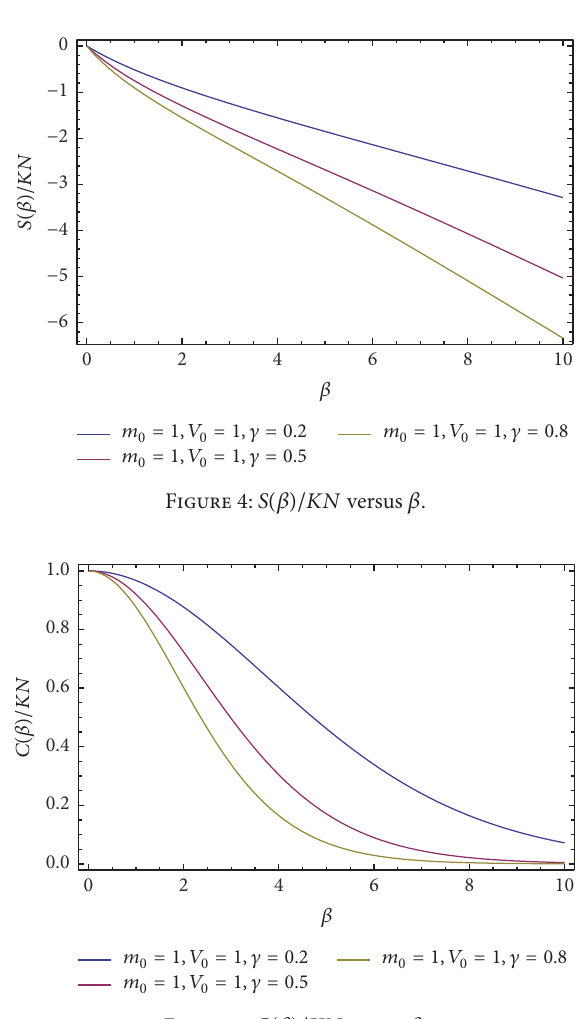
Figure 5: 𝐶(𝛽)/𝐾𝑁 versus 𝛽